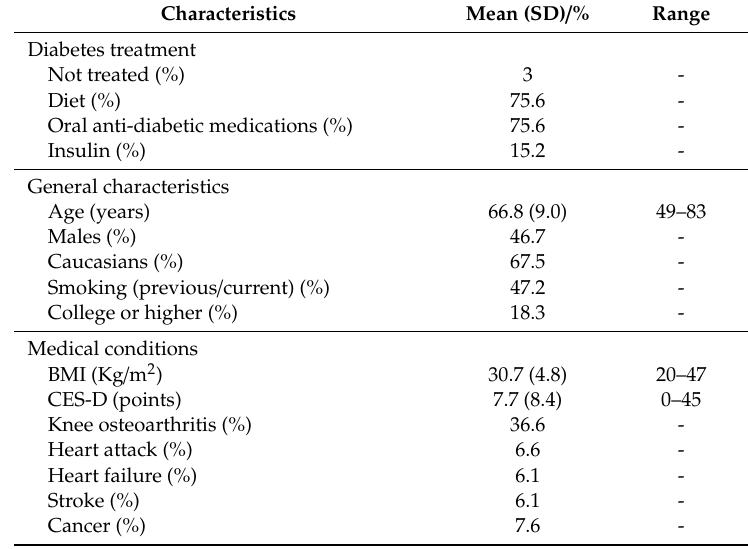
Table 1. Characteristics of the participants with diabetes at wave 6 of the Osteoarthritis Initiative ( n =